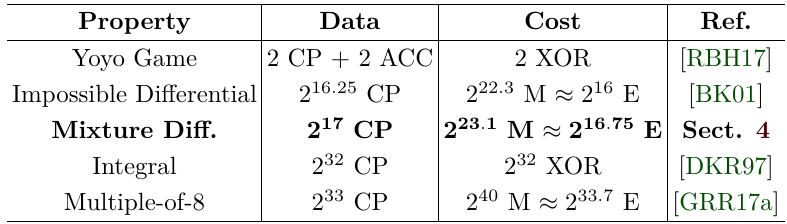
Table 1: Secret-Key Distinguishers for 4-round AES . The complexity is measured in minimum number of chosen plaintexts/ciphertexts (CP/CC) or/and adaptive chosen plaintexts/ciphertexts (ACP/ACC) which are needed to distinguish the AES permutation from a random one with probability higher than 95% (all distinguishers work both in the encryption and in the decryption mode). Time complexity is measured in equivalent encryptions (E), memory accesses (M) or XOR operations (XOR) - using the common approximation 20 M ≈ 1 Round of Encryption. The distinguisher of this paper is in